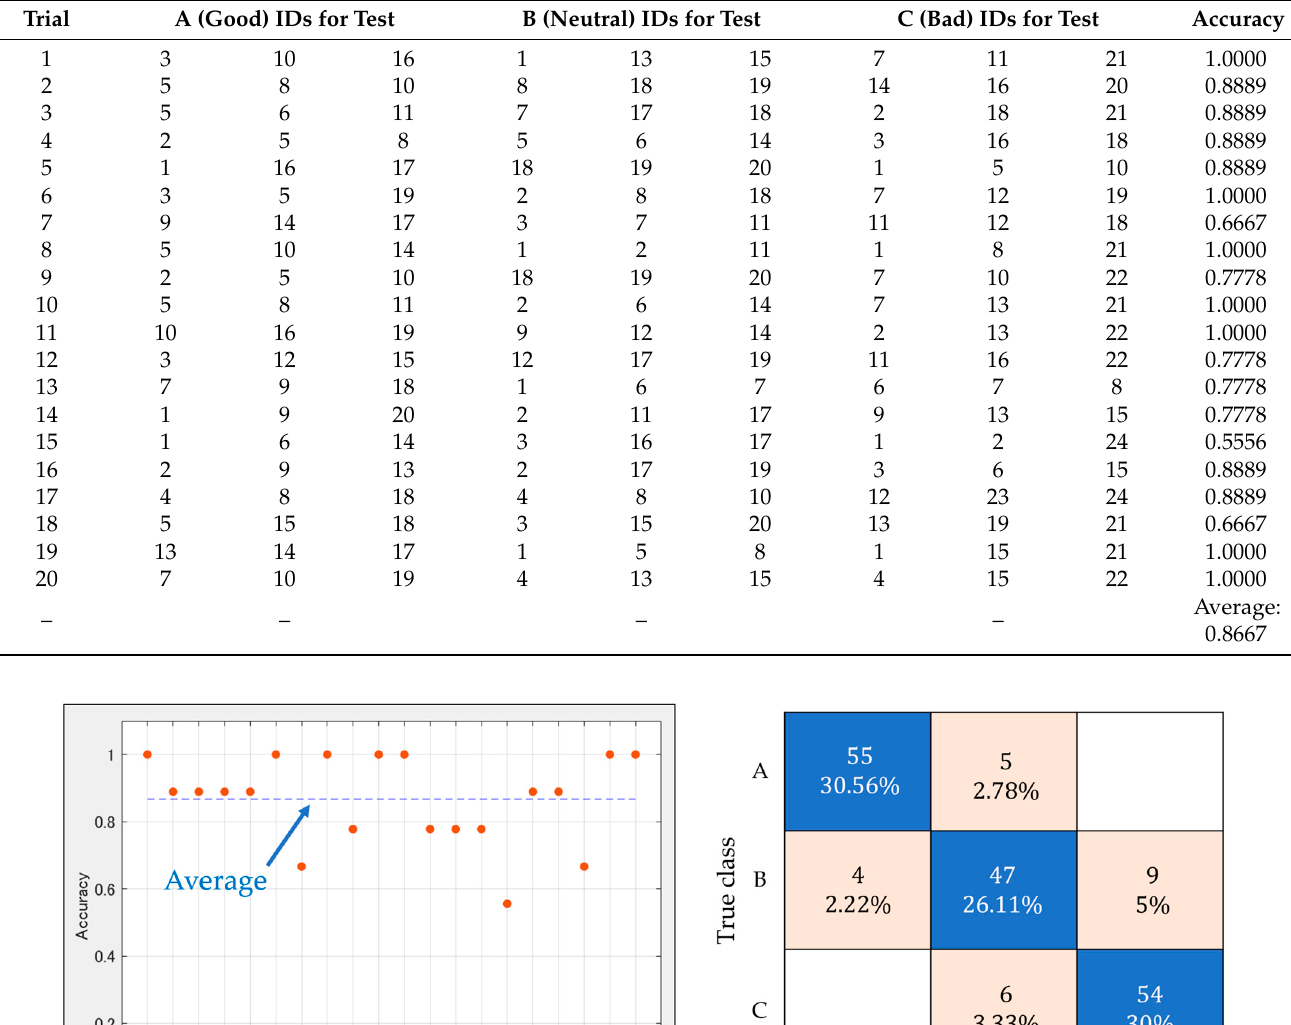
Table 6. Test results of CNN.